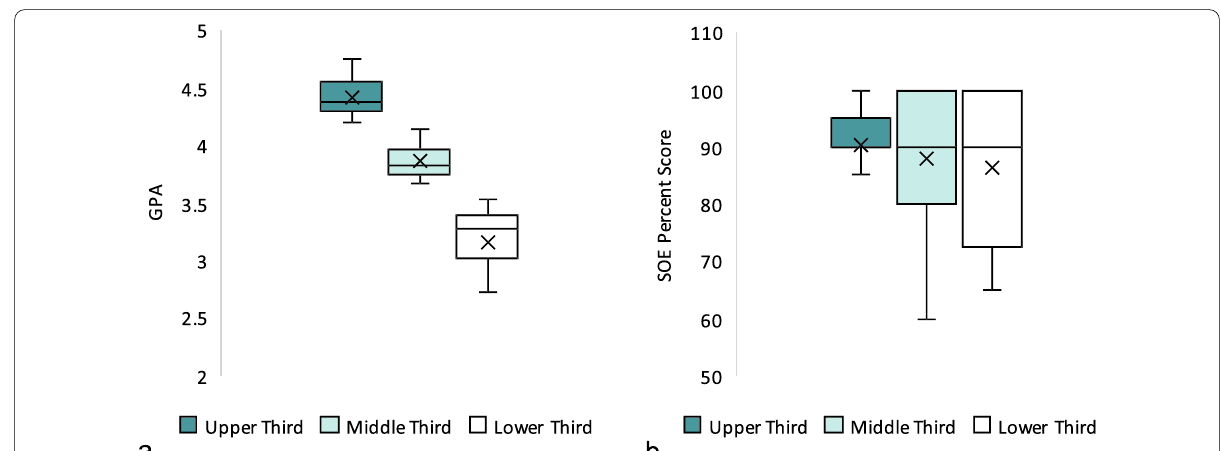
Fig. 7 Comparison of boxplots of GPAs ( a ) and SOE percent scores ( b ) between three levels of students; upper third being students with highest GPAs, to lower third being students with lowest GPAs. The GPA means were significantly different between the three groups, while the SOE percent scores means were